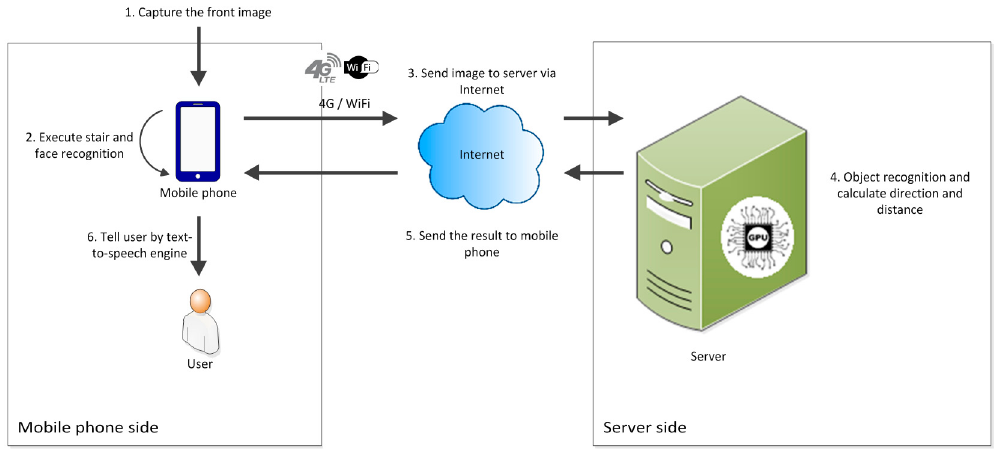
Figure 3. Data and notification message transmission diagram in the online mode.